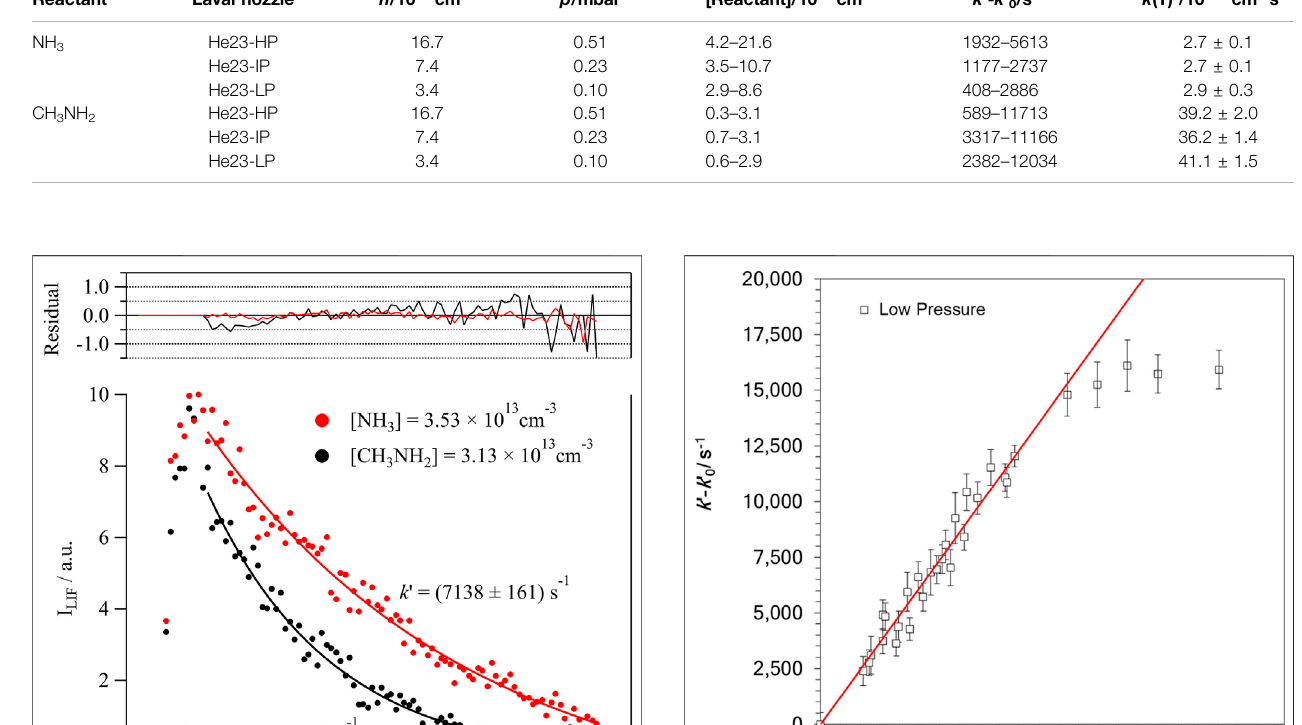
TABLE 1 | Summary of the experimental conditions [total gas density ( n ), jet pressure ( p ), and reactant concentration in the jet] and corrected pseudo - fi rst order rate coef fi cient ranges. Reactant